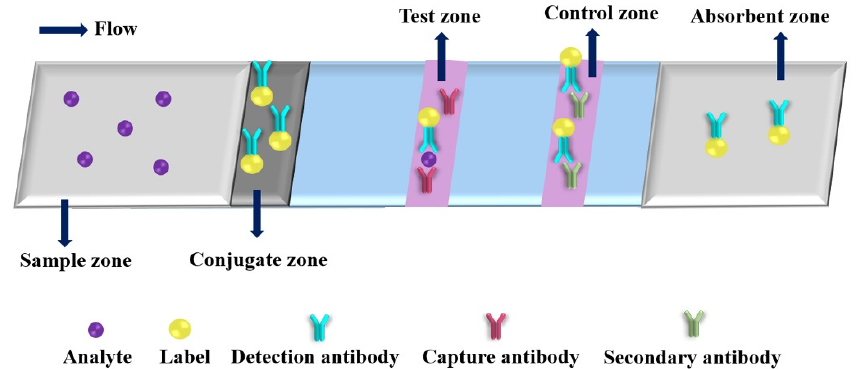
Figure 4. An illustration of a typical colorimetric paper-based analytical device. Table 2. The typical nanomaterial-enhanced colorimetric PADs for sensing various analytes.